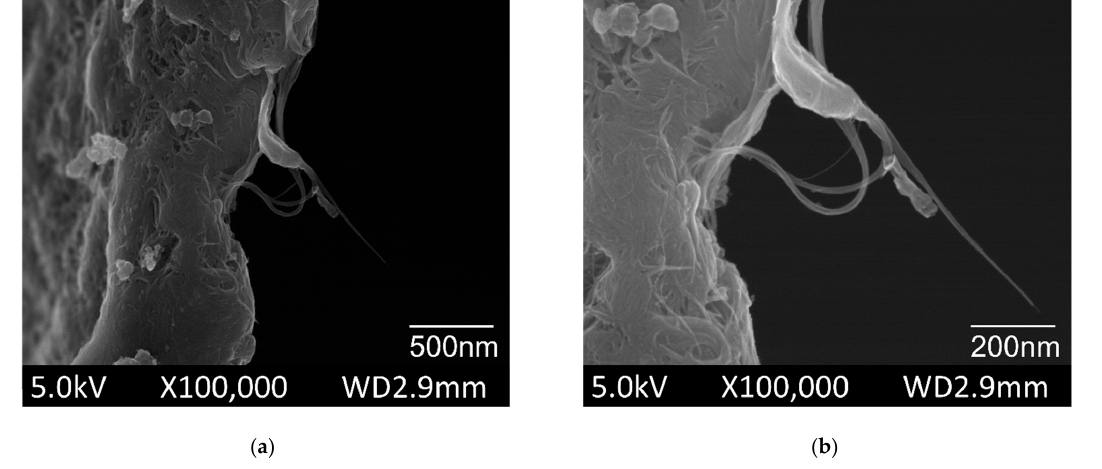
Figure 3. Scanning electron microscopy (SEM) images of the pristine single wallet carbon nanotubes (commercial powder) ( a ) overview of the bundles; ( b ) magnification of the single tube.